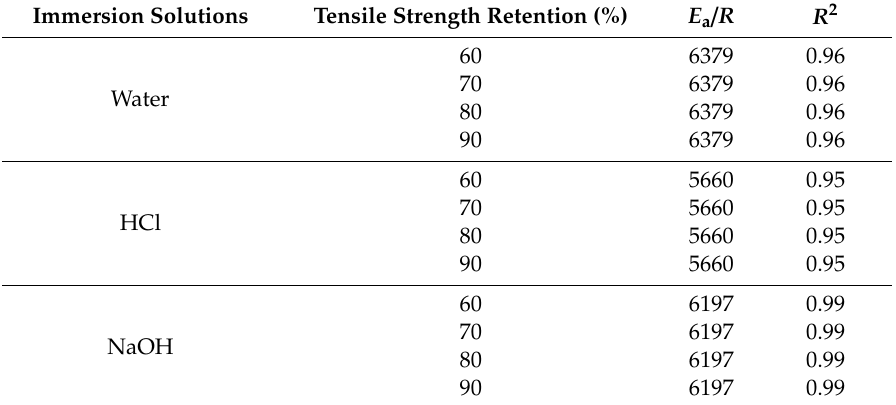
Figure 9. Arrhenius plot of tensile strength retention of CFRP composite in different solutions ( a ) Water, ( b ) HCl and ( c ) NaOH solution. Table 6. Coefficient of regression equation in Equation (5) for Arrhenius plots . Immersion